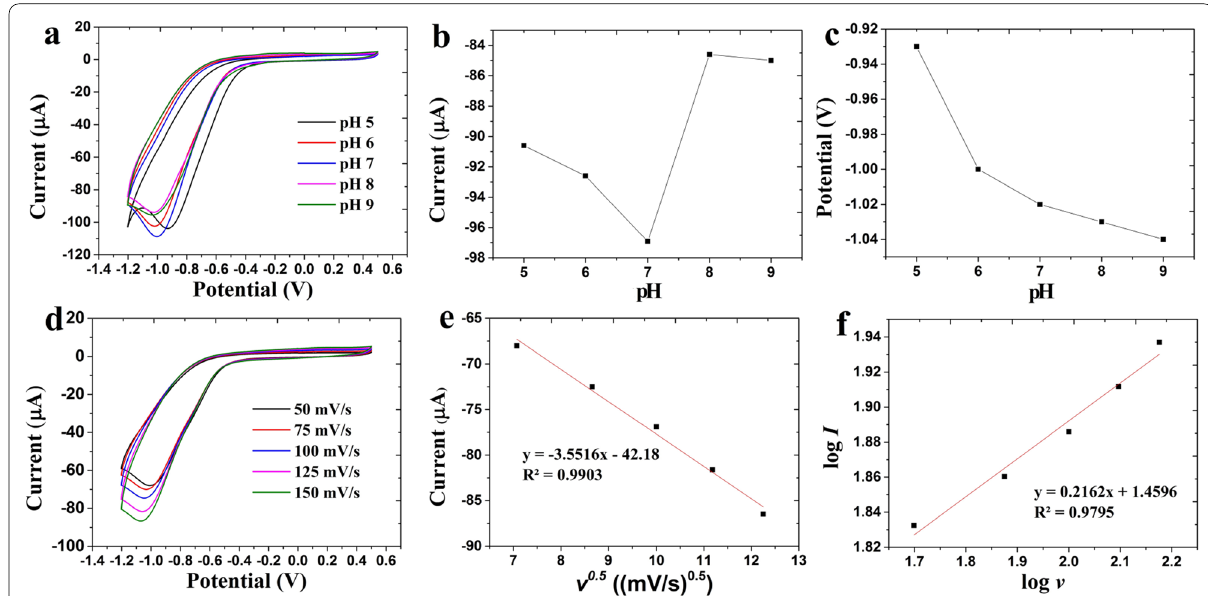
Fig. 4 a CV curves of GCE/ZnO NPs at different pH values (5–9), b plot of pH versus the reduction peak current, c plot of pH versus the reduction peak potential, d CV curves of GCE/ZnO NPs at various scan rates (50–150 mV/s), e plots of v 0.5 versus the reduction current (B), plots of log v versus log I